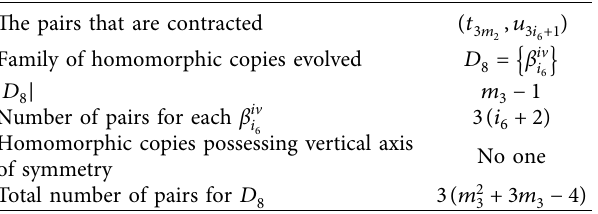
Table 7: Necessary information regarding homomorphic copies 􏽮 􏽯 . β iv i 6